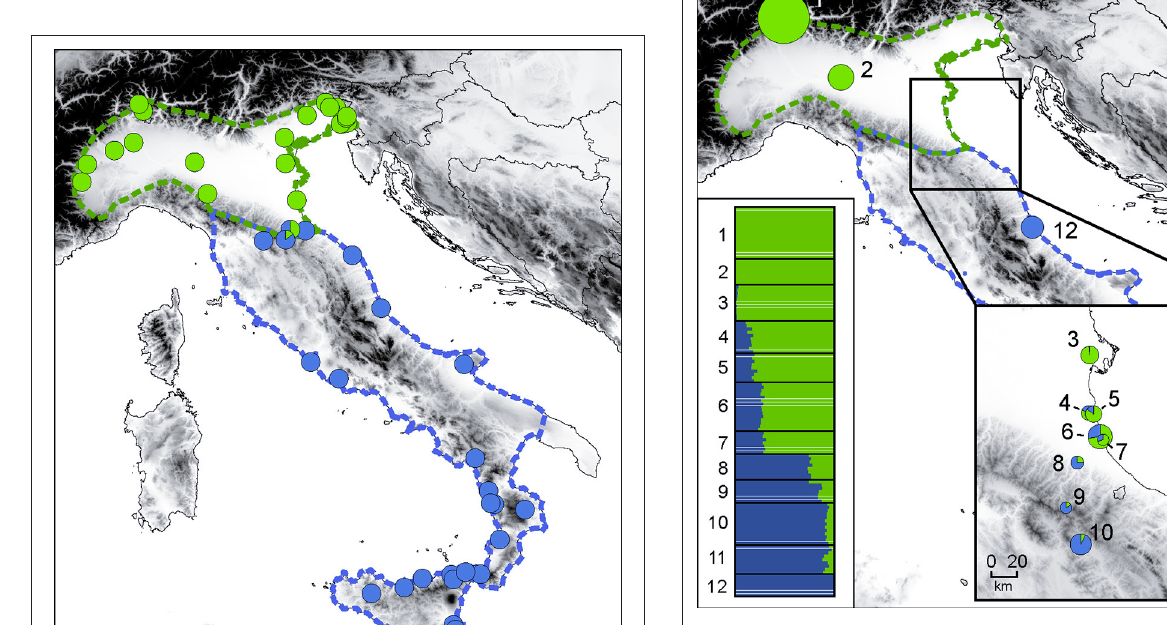
Frontiers in Ecology and Evolution |